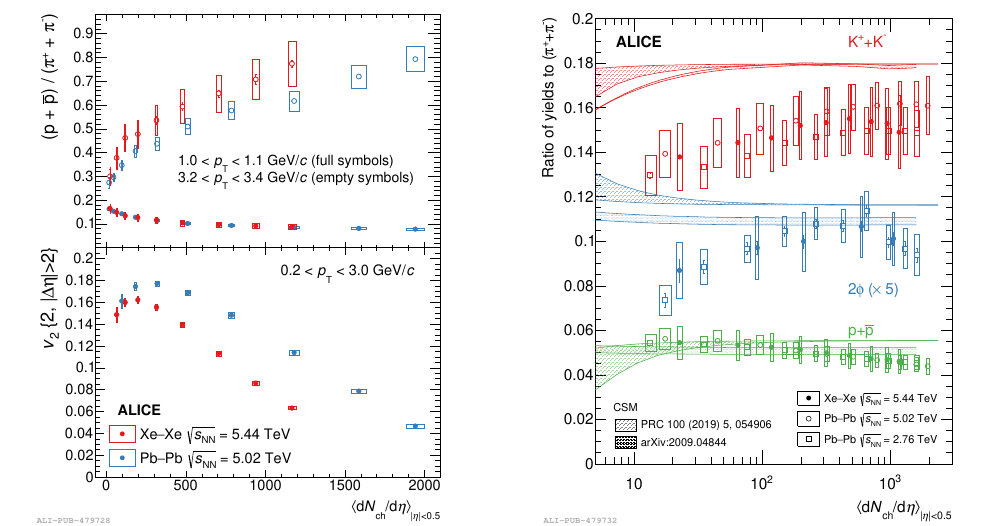
Figure 4. Left figure, top panel: p /π as a function of charged particle multiplicity density in two p T intervals for Xe–Xe √ s NN = 5 . 44 TeV [3] compared to Pb–Pb collisions at √ s NN = 5 . 02 TeV [7, 8]. Left figure, bottom panel: the flow coe ffi cient v 2 tems [9, 10] as a function of charged particle multiplicity density. Right figure: K /π , p /π and p /π for integrated yields as a function of the charged-particle multiplicity density for Xe–Xe collisions at √ s NN = 5 . 44 TeV [3] compared to Pb–Pb collisions at √ s NN = 2 . 76 TeV [11, 12] and 5.02 TeV [7, 8]. Predictions from the canonical statistical model (CSM) are shown as bands considering di ff erent corre- lation volumes [13] (based on [14]) and chemical freeze-out temperatures [15].